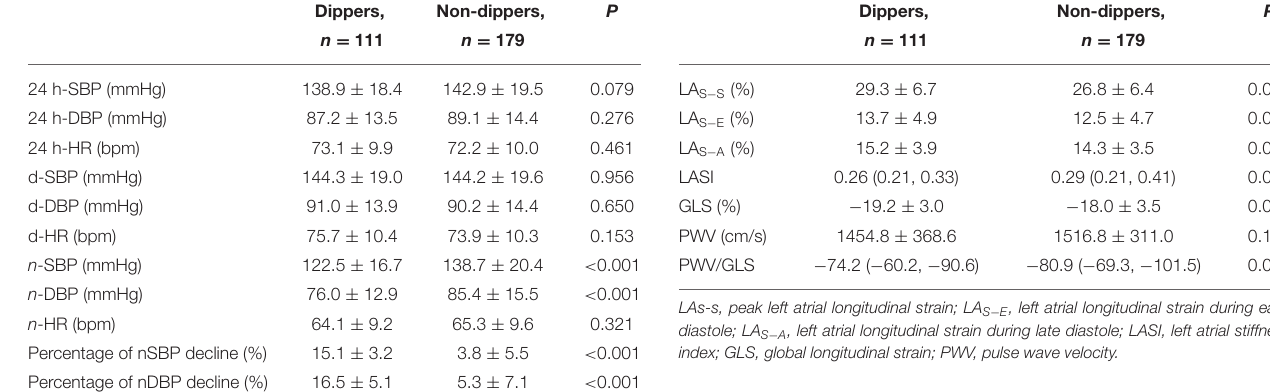
TABLE 2 | 24h ABPM Parameters of the study population. Dippers,